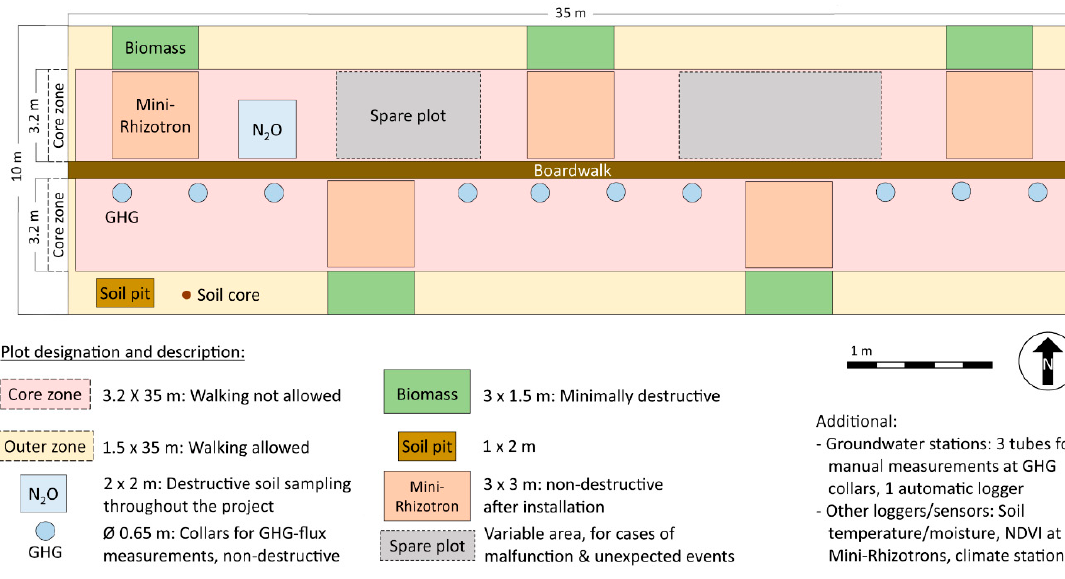
Figure 4. Layout of the monitoring setup at the WETSCAPES study sites. The sites are oriented from east to west wherever possible, but in some cases, they are slightly tilted to be able to cover similar vegetation across the whole